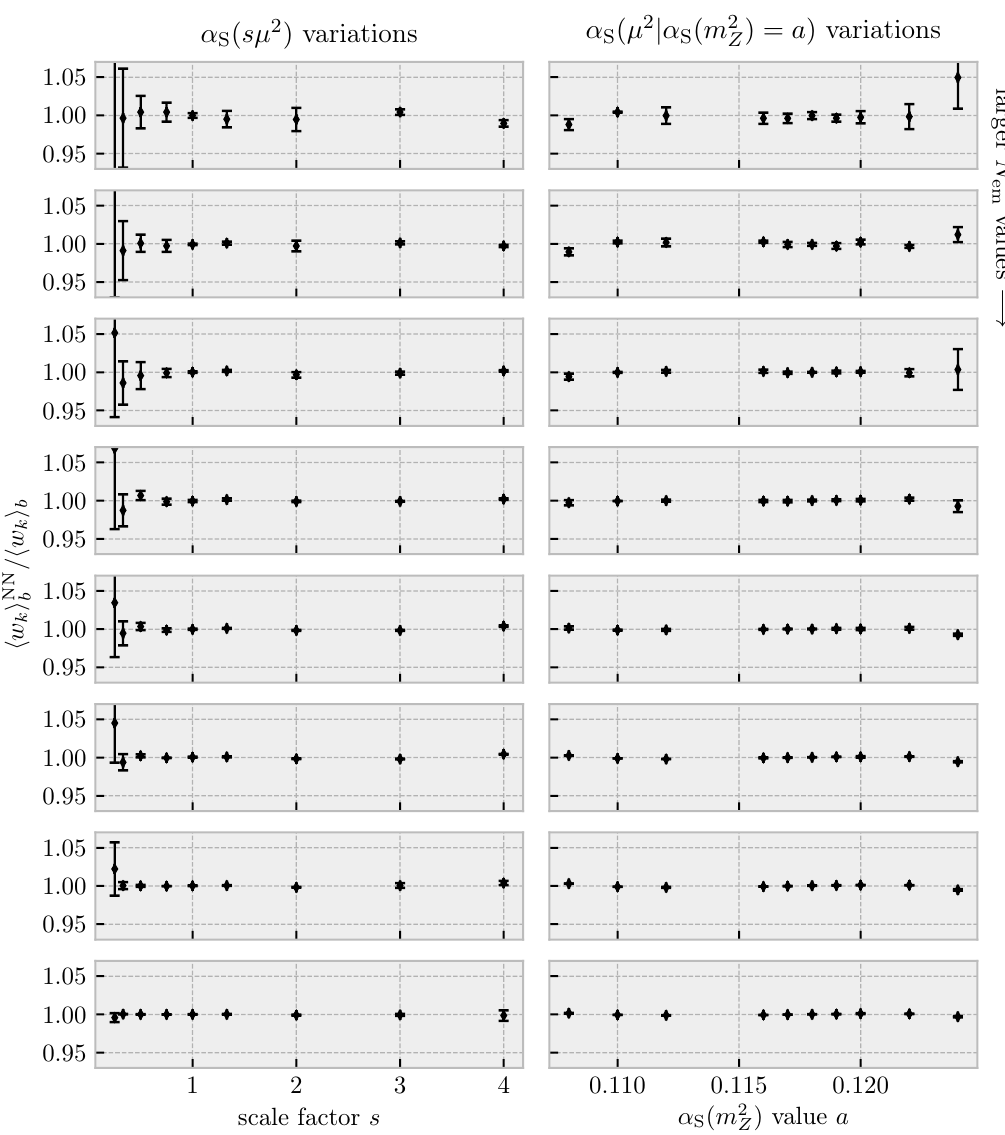
Figure 6 . Ratios between neural-net-predicted and true reweighting factors for each bin of the N em histogram, see (cid:12)gure 5. Each row corresponds to one bin, with the smallest- N em bin at the top. The two columns correspond to scale and (cid:11) S ( m 2